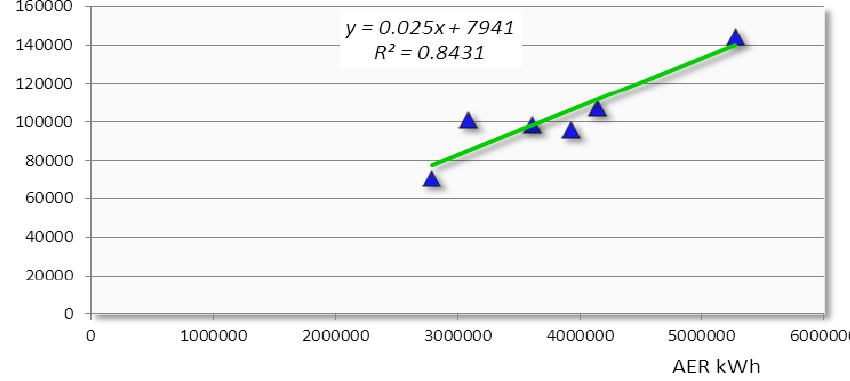
Figure 2. Correlation of municipal built volume (m 3 )-AER. Source: elaboration of the Research Unit